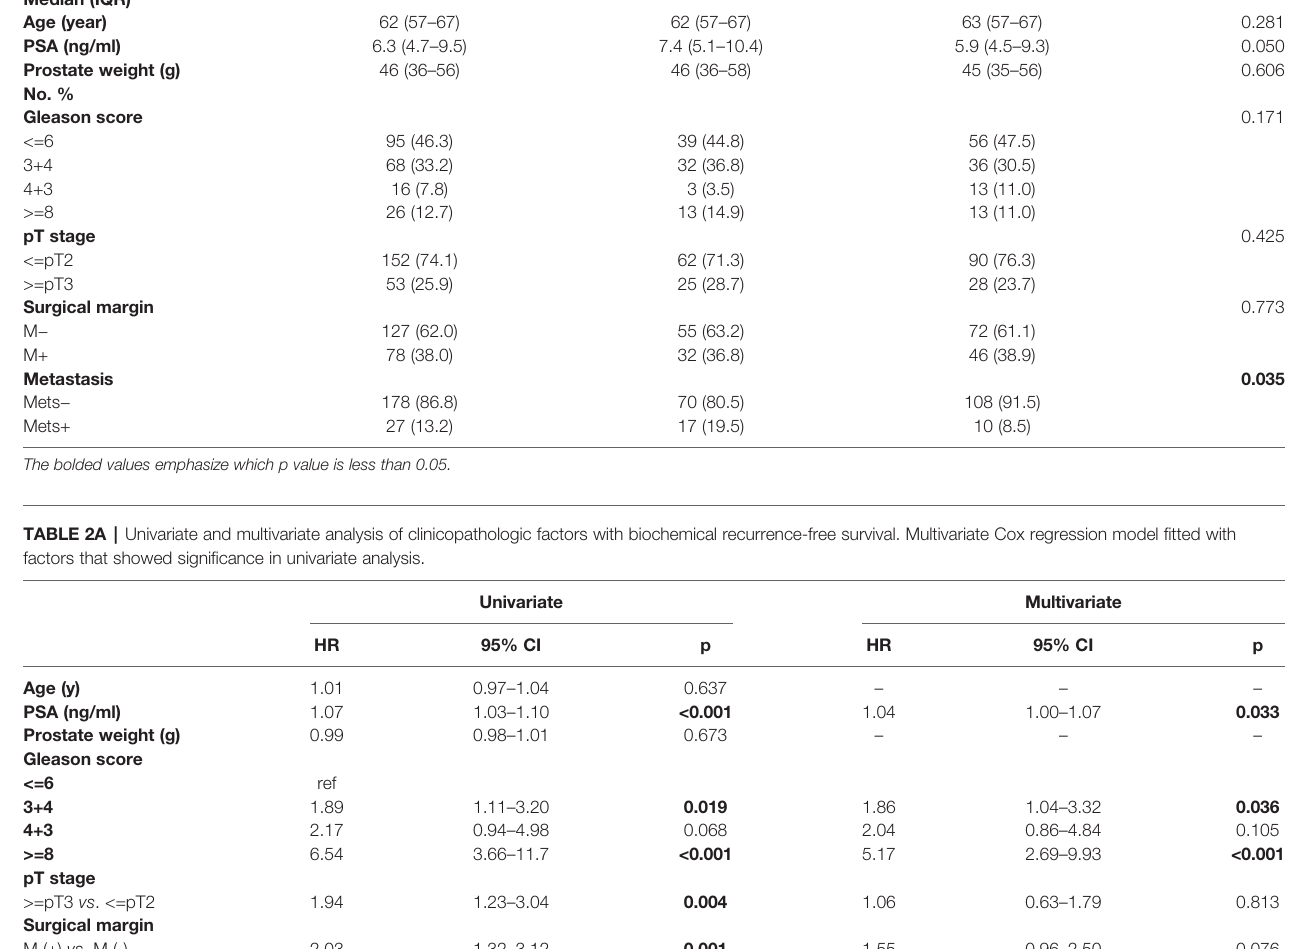
TABLE 1 | Association of TFEB expression in prostate cancer cells with clinicopathologic characteristics in 205 patients who underwent radical prostatectomy between 1993 and 1995 in Massachusetts General Hospital. Total TFEB (high) p Patients, no. %